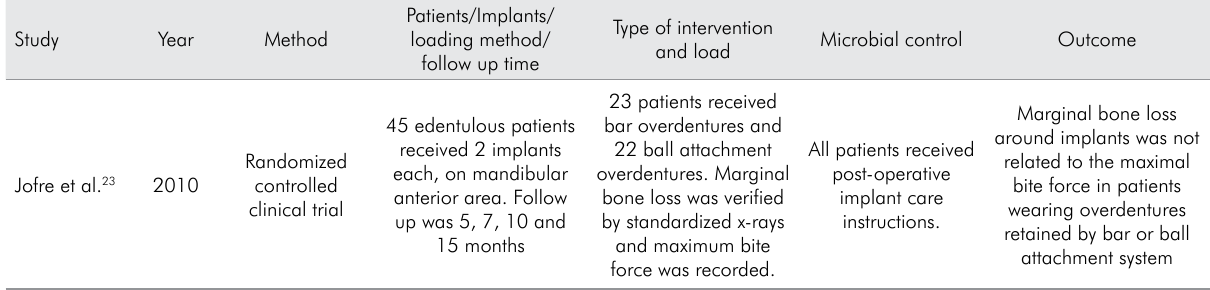
Table 5. Study characteristics and quality assessment of the human studies included for the